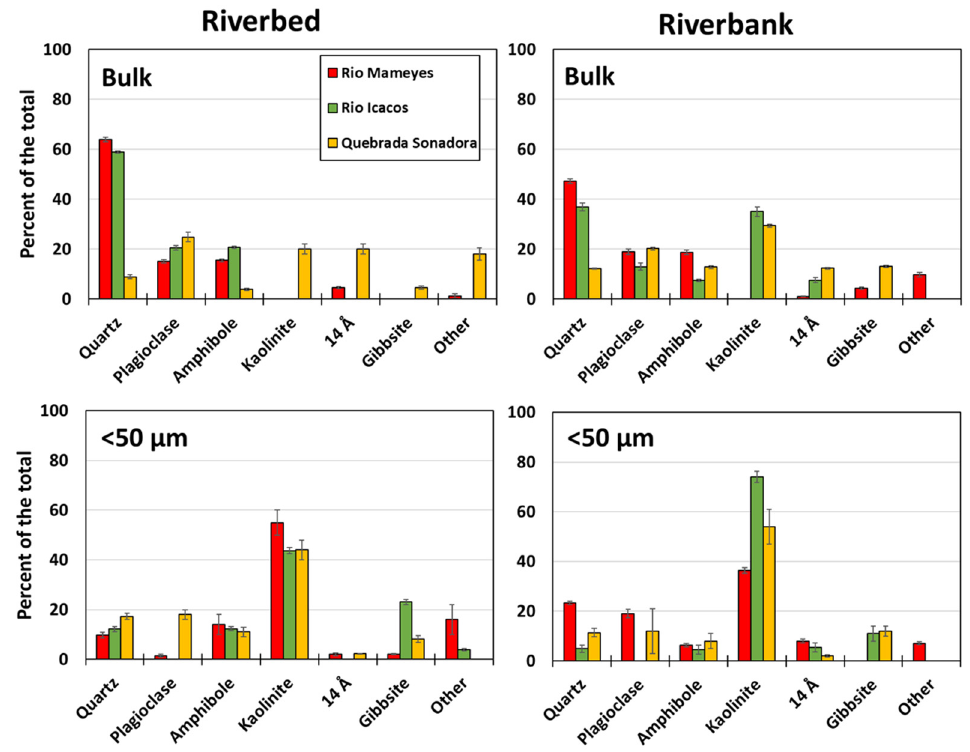
Figure 3. Relative mineralogical composition of river sediment grab samples collected in February 2022. Bulk correspond to the bulk composition and <50 µm to the composition of the <50 µm con- centration. Results are from the Rietveld refinement of diffractograms presented on Figures S2 and S3.